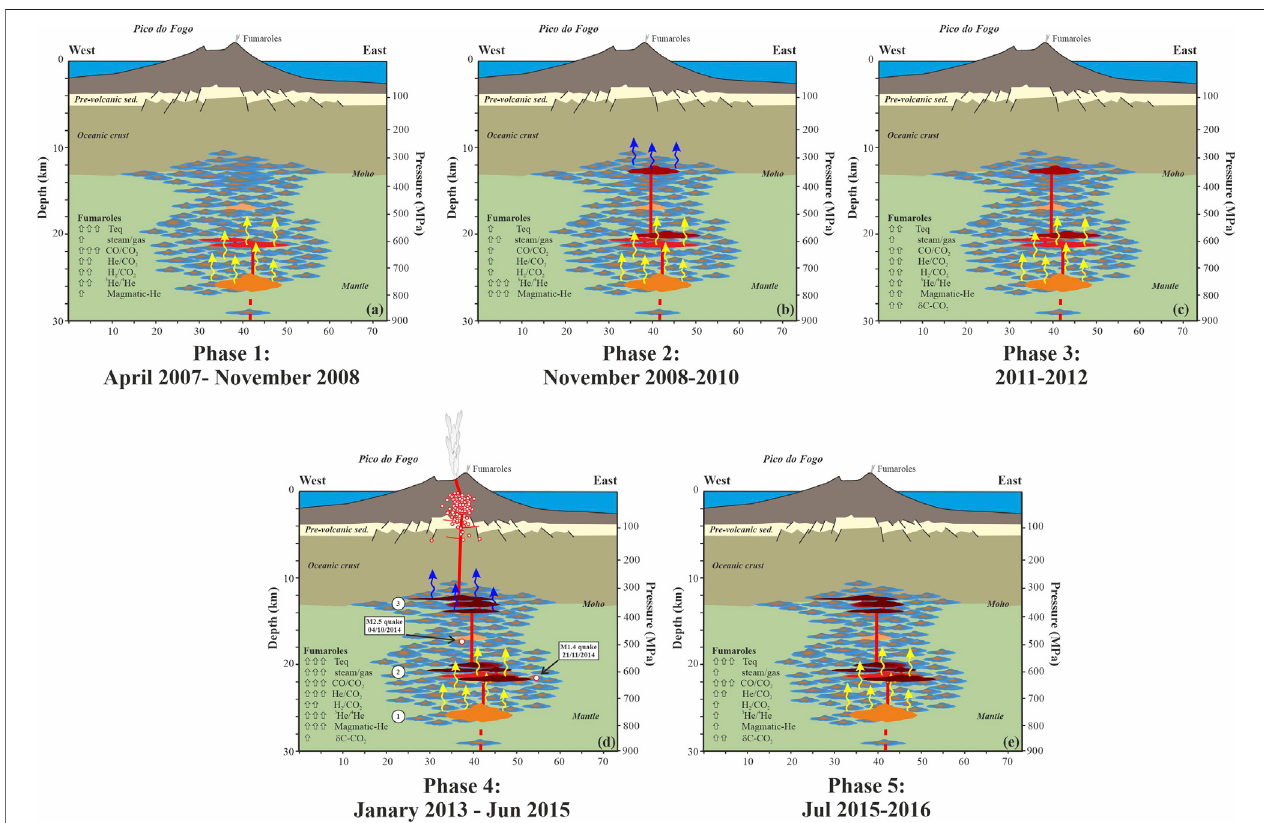
FIGURE 13 | Schematic model for the Pico do Fogo volcano fumarolic gas discharge during the period 2007 – 2016 [modi fi ed from Klügel et al. (2020)].